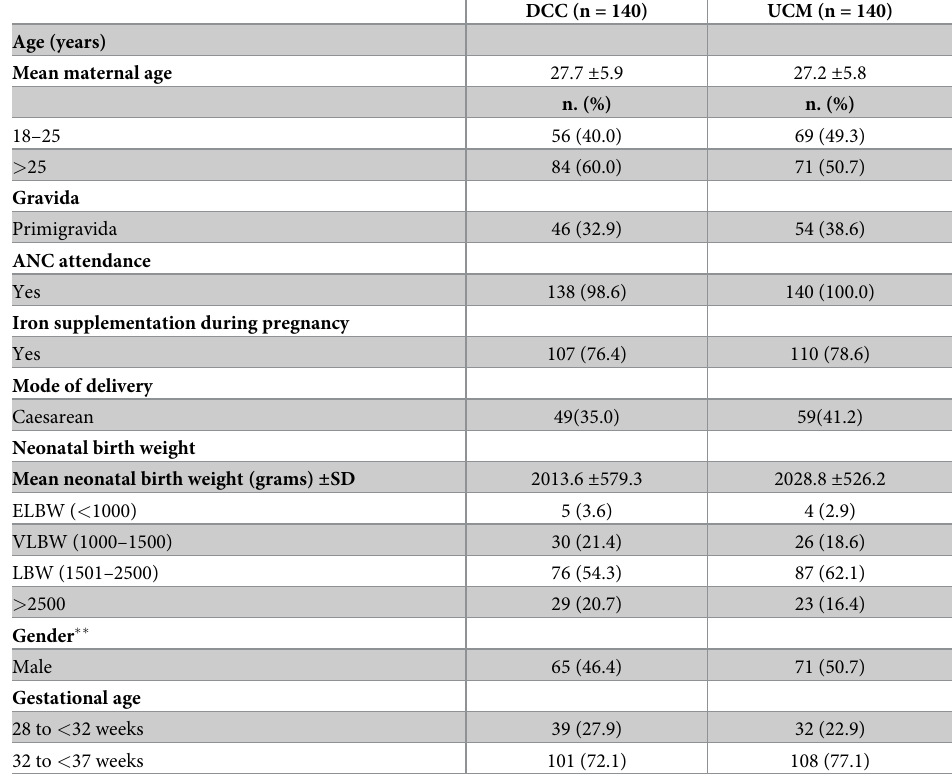
Table 1. Baseline sociodemographic and clinical characteristics of participants who underwent umbilical cord milking versus delayed cord clamping between March 2018 to May 2019 at Kenyatta national